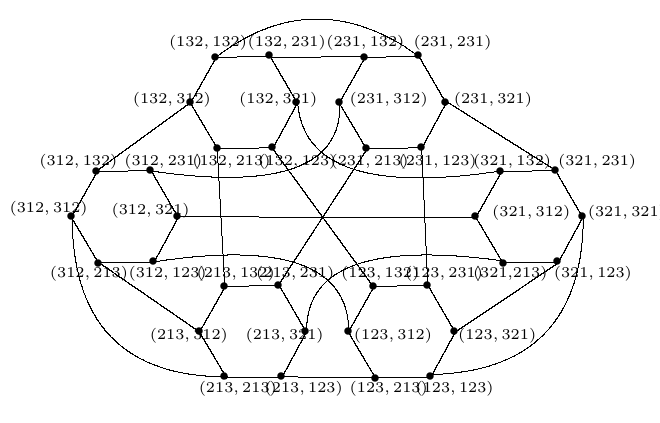
Fig. 1: Hierarchical star network HS